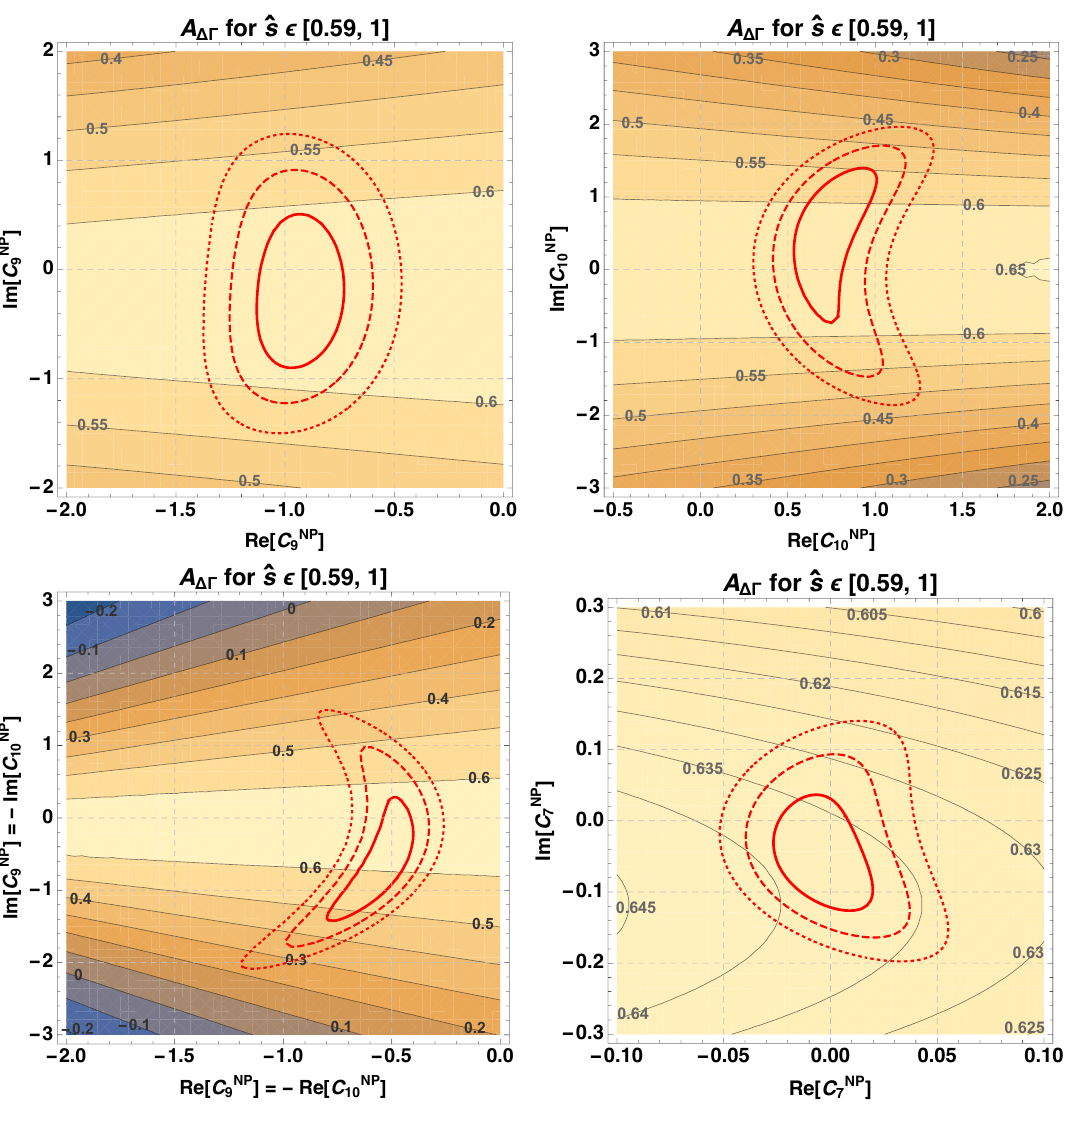
contours in the Re( C NP ) vs. Im( C NP ) plane, for i = 7 , 9 , 10 , and for the scenario Figure 4 . A µµγ i i ∆Γ s Re vs. Im of C NP = − C NP . The solid or dashed or dotted contours denote respectively the 1, 2 9 10 and 3 σ regions allowed by the global fit discussed in section 3. See text for further